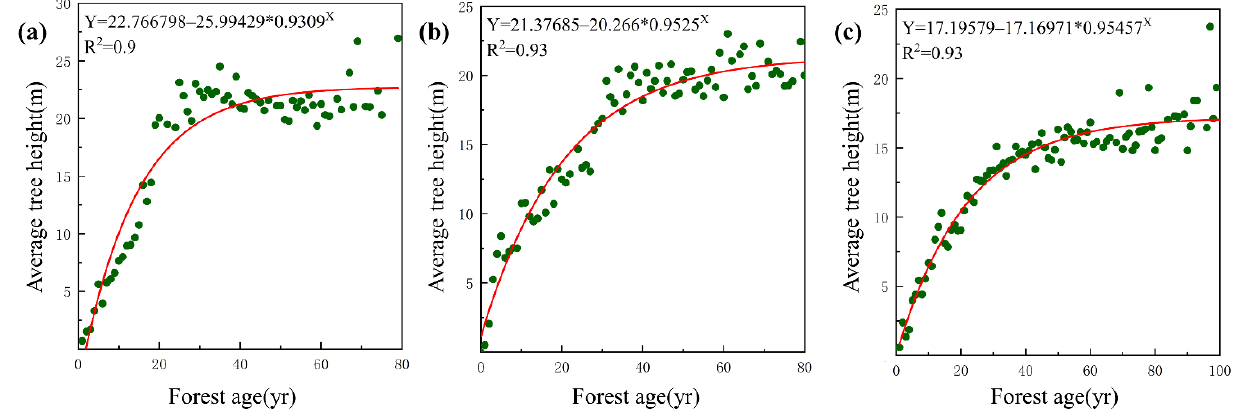
Figure 5. Growth curves of three forest types. ( a ) Needleleaf forest. ( b ) Broadleaf forest. ( c ) Mixed forest.